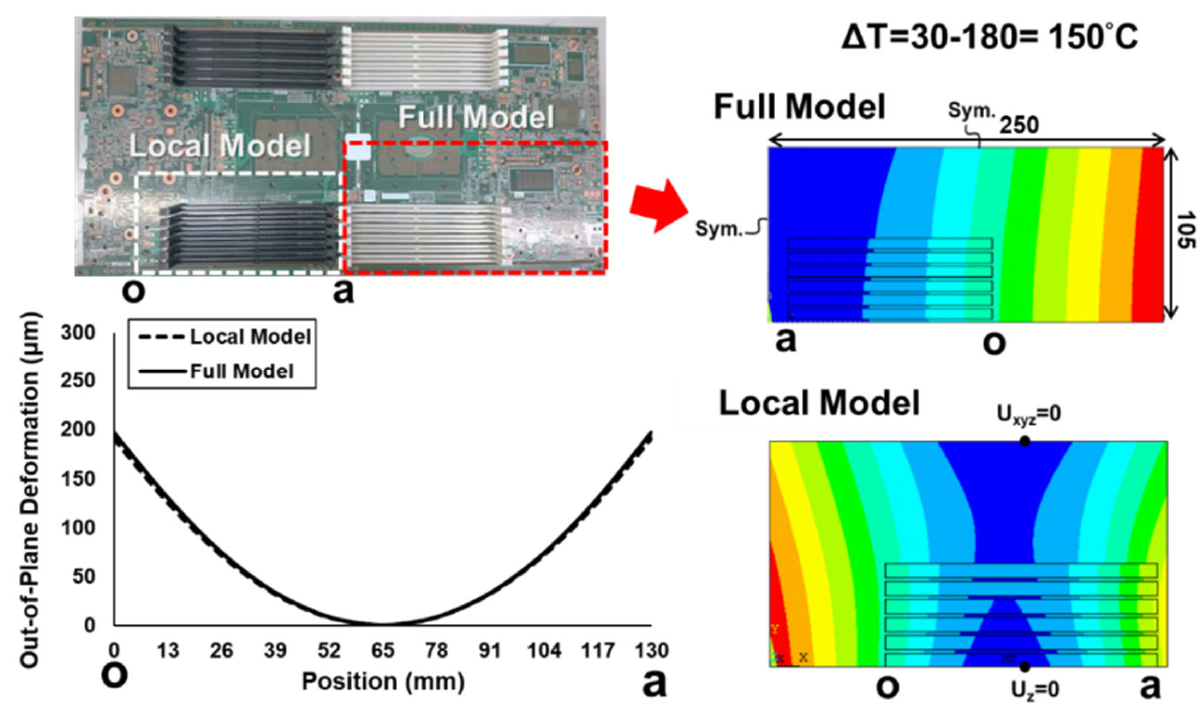
Figure 14. The out-of-plane deformations along the socket line o-a and their contour maps for the socket-PCB assembly under thermal loading Δ T = 150 °C, determined from the FEM simulation using a local model and a full model.